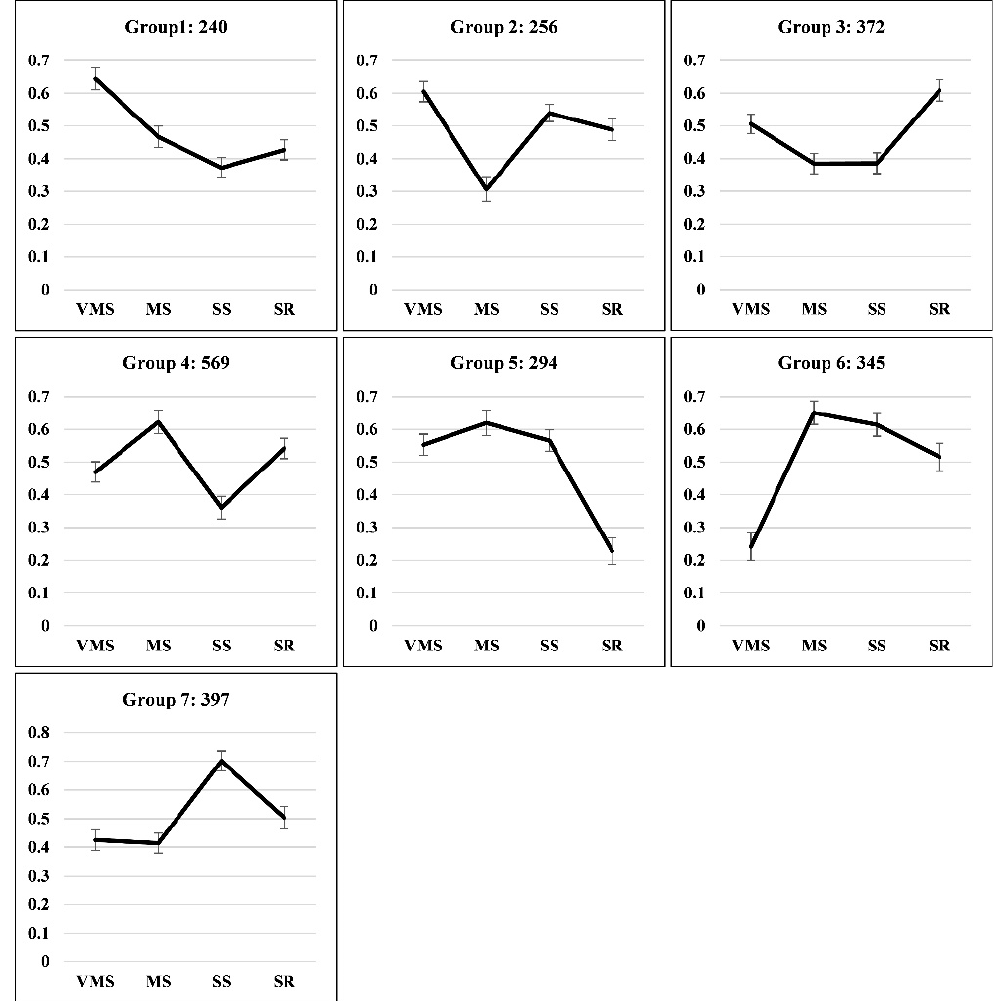
Figure 3. Cluster analysis of stress-responsive AS events in soybean root displayed on the basis of their isoform expression percentage (IEP) variations under various drought conditions. (IEP = Average ∆ PSI (ww)/ (Average ∆ PSI (ww) + Average ∆ PSI (stress)). The number of AS events in each cluster is listed. The x -axis shows various stress conditions, and the y -axis shows IEP value. The black lines indicate the trends of average IEP value for all AS events in each cluster.